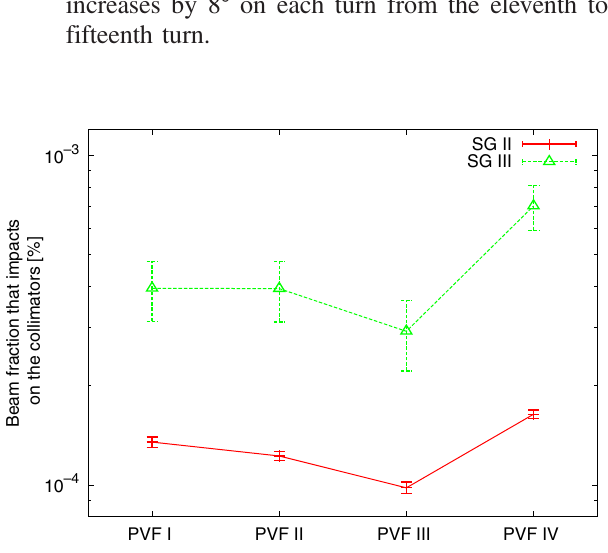
FIG. 9. Beam fraction that impacts on the collimators for the four PVF cases using the SG II and SG III distributions.